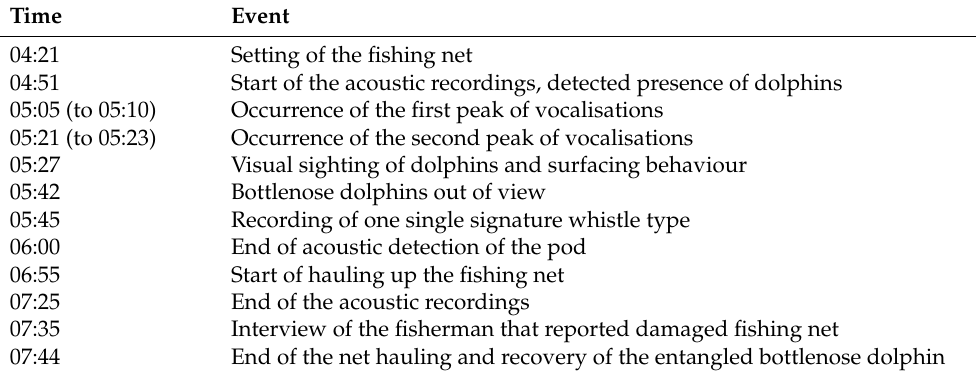
Figure 1. ( a ) Study area and position of the recording array (green dot), the entangled dolphin (red dot), and the fishing net (dotted line); ( b ) carcass of the bottlenose dolphin. Adapted with permission from Marecamp association, 2021. Table 1. Chronological order of the